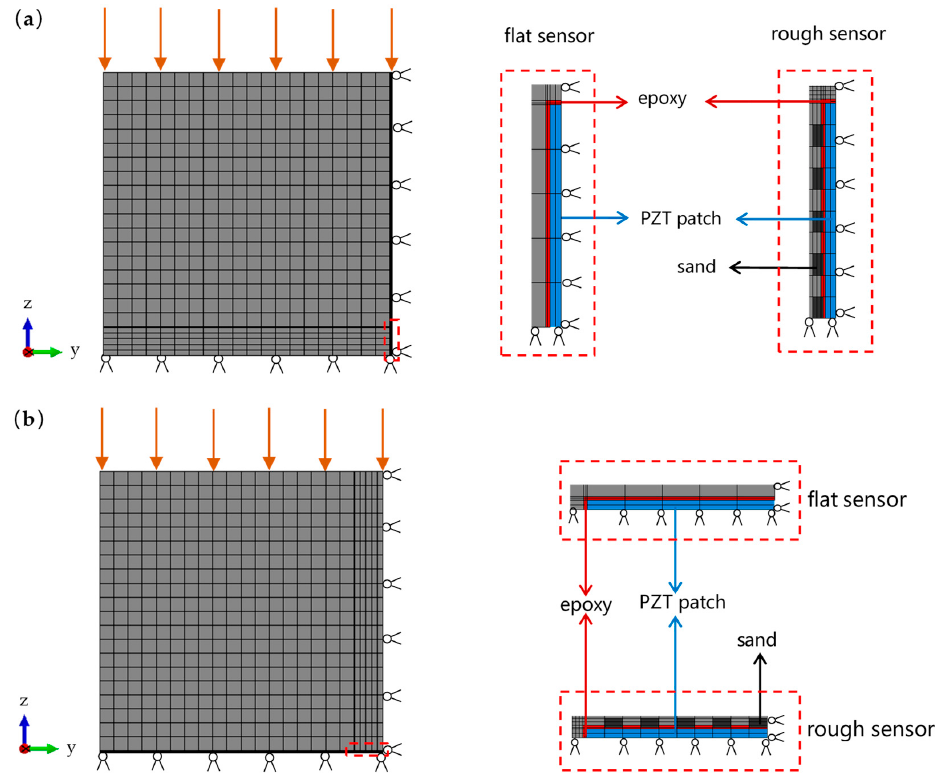
Figure 15. FE models for the typical specimens with the ( a ) 90° and ( b ) 0°